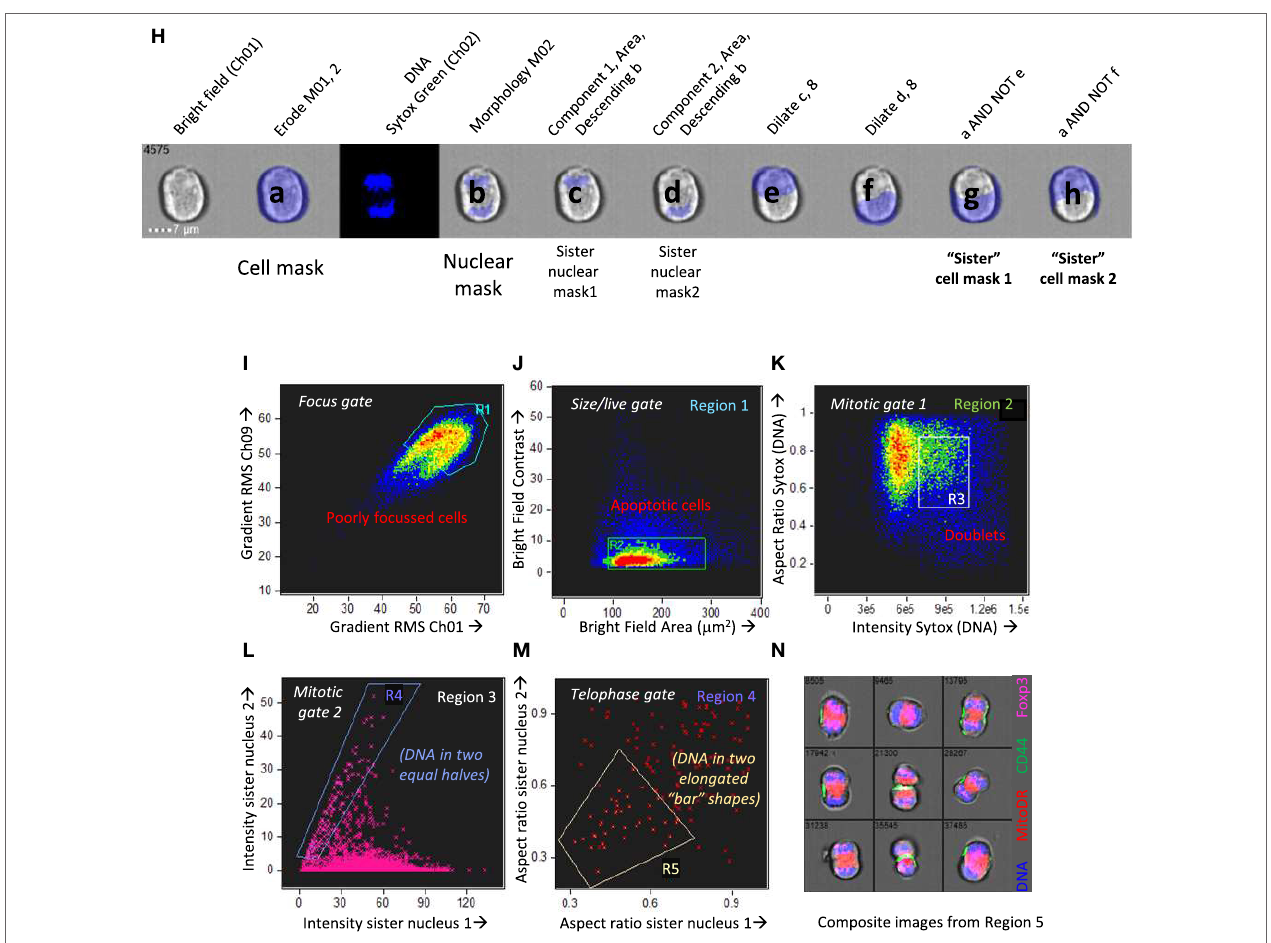
FigUre 1 | Masking and gating strategies for analysis of uropodia and cells in telophase. The strategy for making masks (blue shading) for nuclear expression and identification of uropodia is shown in (a) . The bright field (Ch01) default mask (M01) was first eroded, either by two pixels or, when a significant number of images contained a lot of extraneous material (as seen at the bottom right of the example shown), by using an 80% adaptive erode (a) followed by a 5 or 6 pixel dilation, to generate a “clean” cell mask (b). The nuclear mask was then made using the morphology function of the DNA (7AAD, Ch05, mask M05, shown in c). The uropodium mask (f) was defined as the largest area single component of the clean cell mask (b) after subtraction of the nuclear mask (c) dilated by 6 pixels (d). (b–g) Image gating strategy for defining cells with uropodia. Images were gated for focus (b) , size (bright field area) and non-apoptotic (low bright field contrast) (c) . Note that it is essential that images are gated on diploid (ideally G 0 /G 1 DNA staining intensity) with an aspect ratio > 0.8 (i.e., a single, round nuclei) (D) . Dead cells staining with live/dead aqua were excluded (e) . The area of the uropodium mask for each image was then plotted on a frequency histogram (with a log scale for uropodium area) and cells with uropodia areas greater or lesser than 10 µm 2 were defined as uropodia positive (red) or negative (blue), respectively (F) . The uropodium mask was also used to show the proportion (%) of any stains of interest that were differentially expressed within or outside the uropodium mask [an example is shown for mitochondria in (g) ]. (h–n) The strategy for making masks (blue shading) to identify and determine the polarity of telophase cells is shown. A cell mask was made by eroding the default bright field mask (M01) by two pixels (a). A nuclear mask was generated by applying the morphology function to the default DNA channel (Ch02, M02 for Sytox Green shown). The component function (component 1 and 2 sorted for largest area) was then used to identify the DNA staining for the two condensed sister nuclei (c, d) which were dilated by eight pixels (e, f) and then each was subtracted from the cell mask (a) to give the two sister “cell masks” (g, h). The gating strategy to identify cells in telophase (and late anaphase) is shown in (i–n) . Images were gated for focus (i) , size (bright field area), and non-apoptotic (low bright field contrast) (J) , singlet cells with G 2 /M DNA content (K), and live cells excluding live/dead aqua (not shown). Cells in late anaphase and telophase were selected by gating for images with two nuclear components of similar DNA stain intensity (l) and low aspect ratios [i.e., with condensed “bar” shaped nuclei: (M) ], with examples shown in (n) (DNA in blue, mitochondria in red, and CD4 in